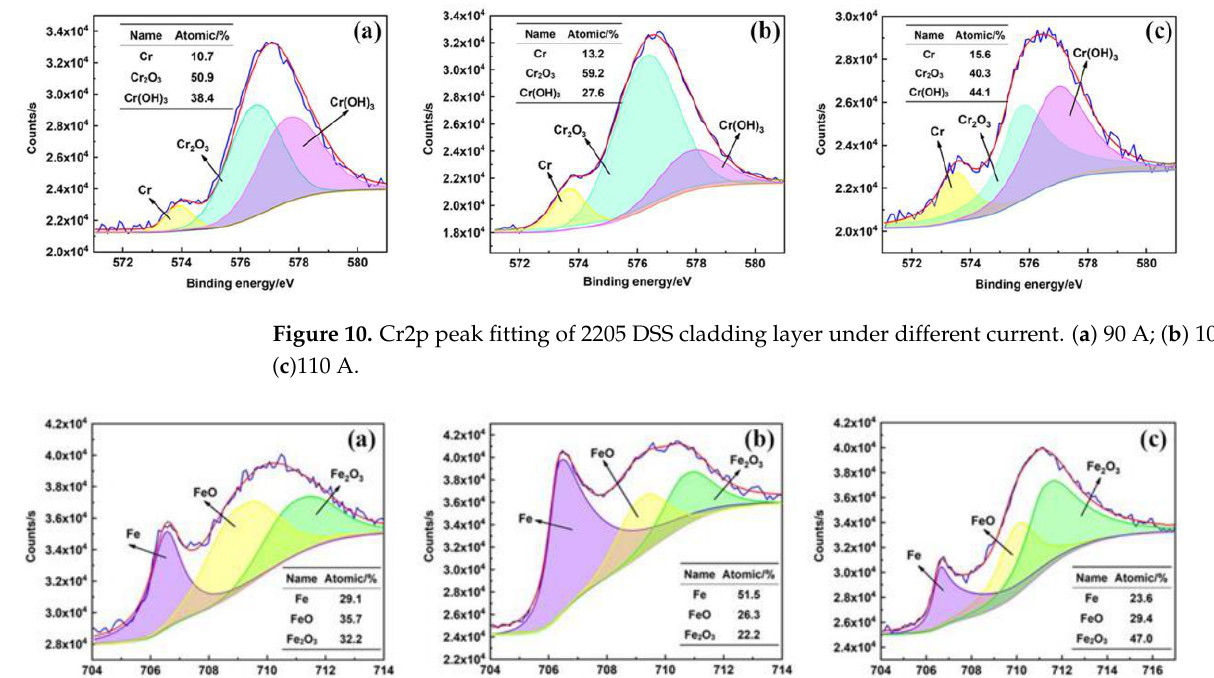
Figure 10. Cr2p peak fitting of 2205 DSS cladding layer under different current. ( a ) 90 A; ( b ) 100 A; ( c )110 A.